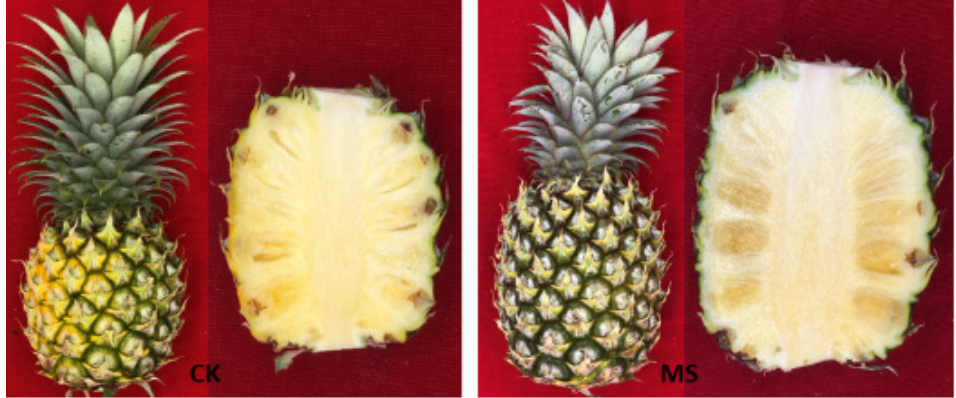
Figure 1. Fruit and pulp of normal fruit (CK) and mildly watercored (MS)